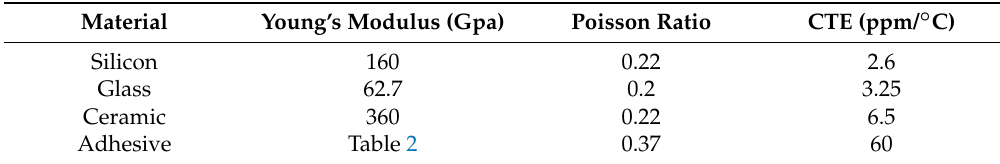
Table 1. Material properties for the sensor.